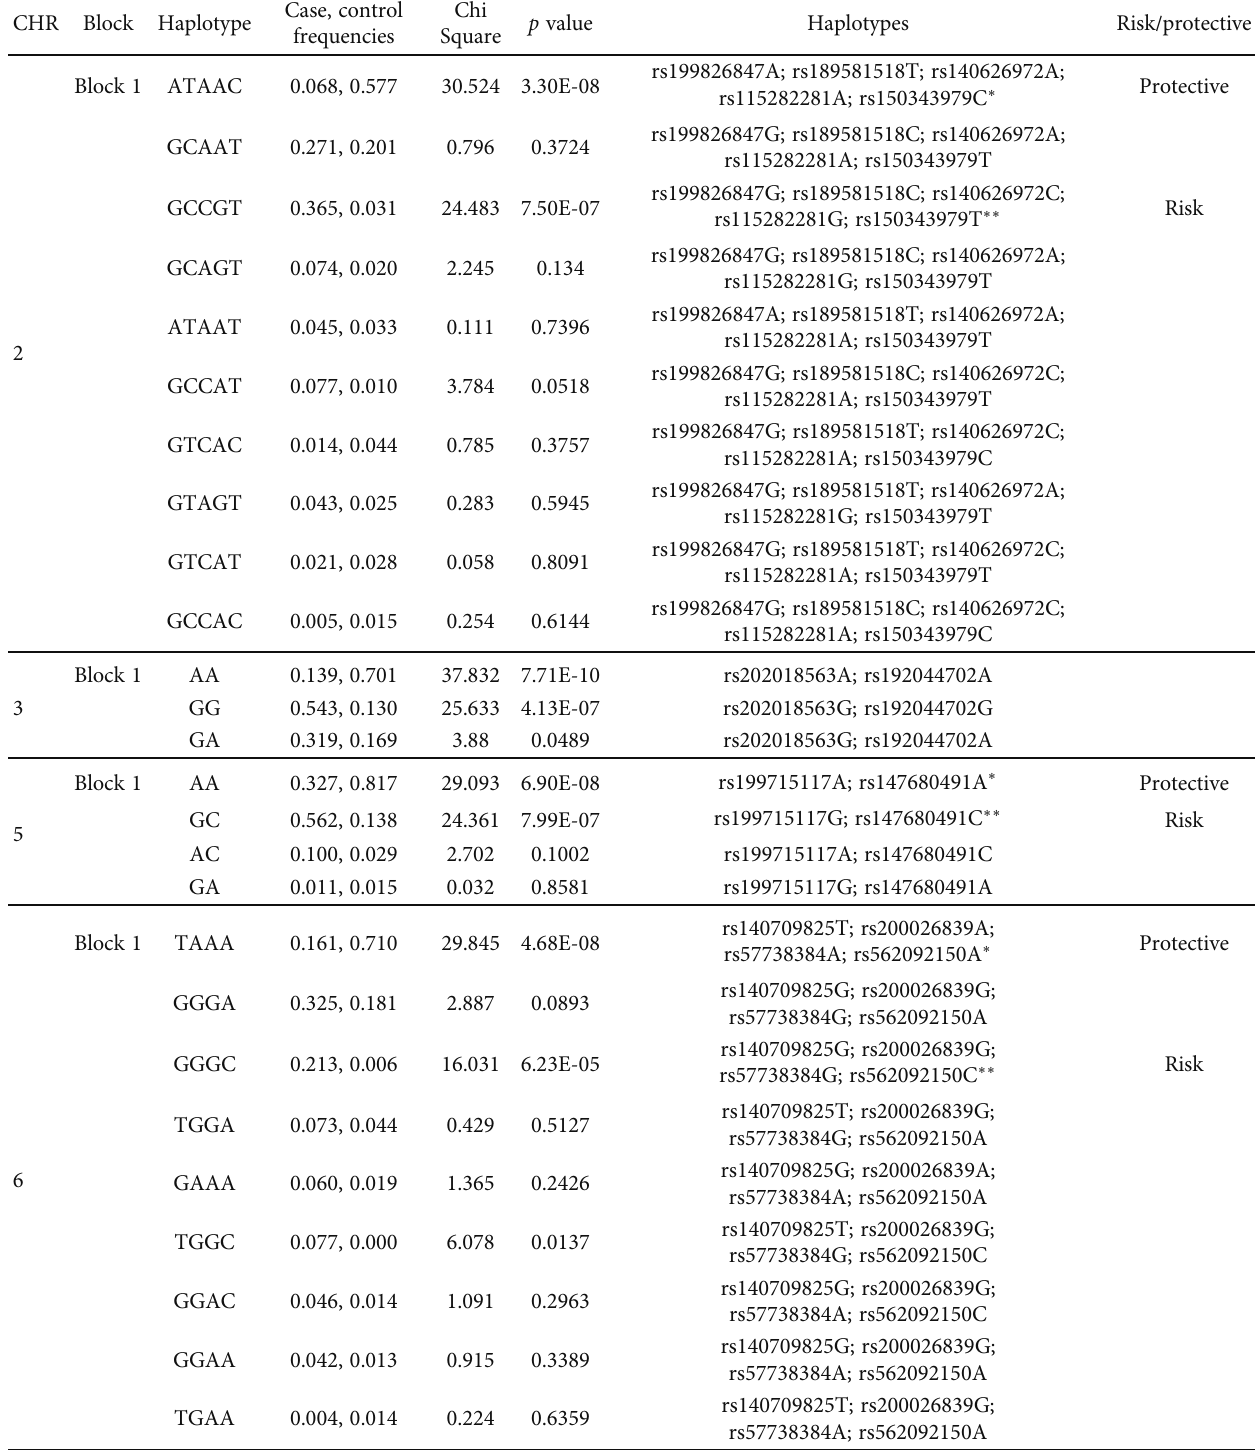
Table 3: Haplotypes of SNPS with the signi fi cance p ≤ 9 : 23 × 10 − 07 in Saudi females with breast